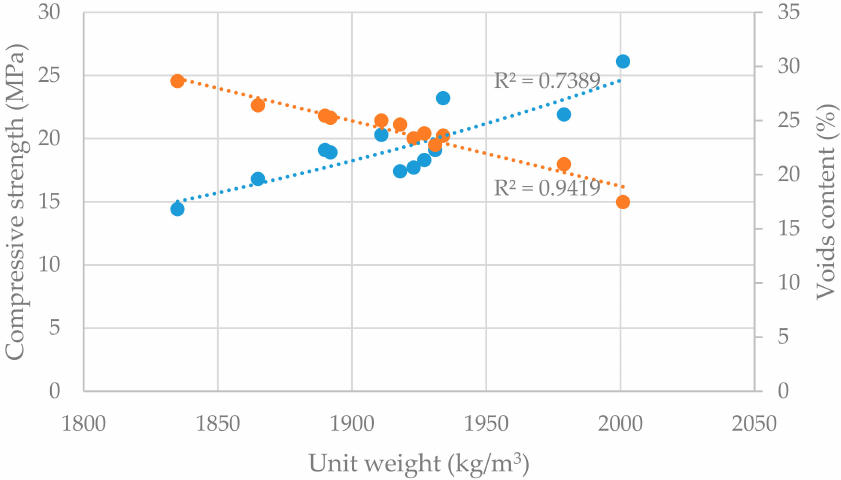
Figure 4. Interaction between compressive strength, unit weight and void content of pervious concrete